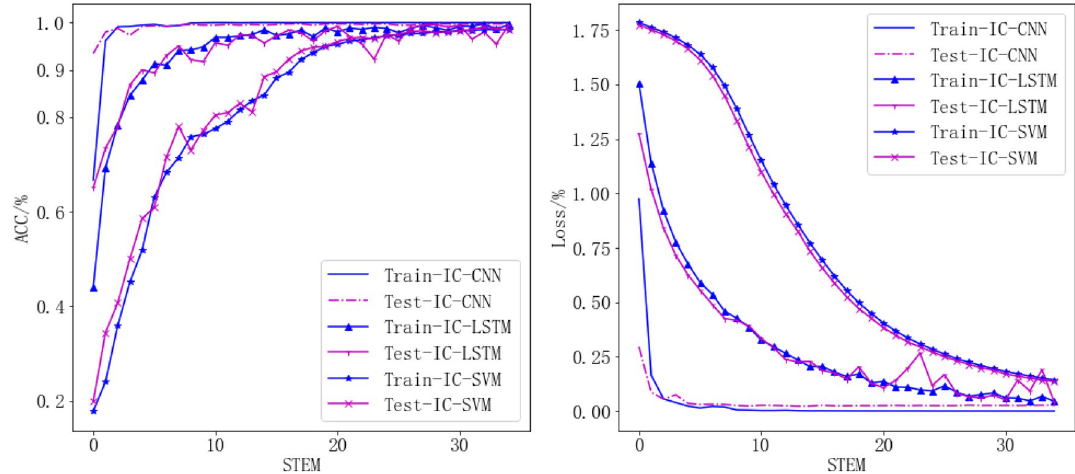
Fig. 6 Accuracy and Loss of each model in dataset